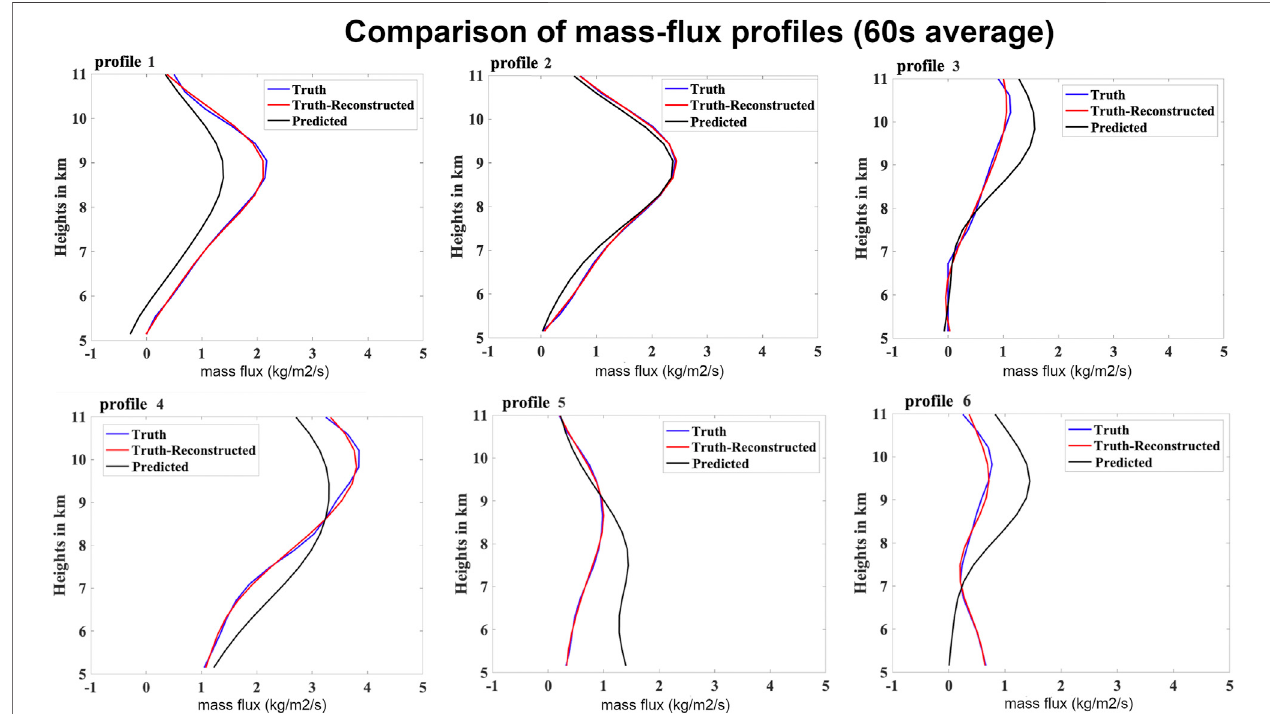
FIGURE10| Sixexamplesofpro fi lesofverticalmass fl uxretrievedtheTbsobtainedattandt+dt:theTbsareusedtoestimatew max andh max ,whicharecombined to the cloud top height (CTH) and the top three principal components of each pro fi le obtained from a PCA (see text for details). The blue curve is the original pro fi le, and the red curve is the reconstruction of that pro fi le using only its top three principal components. The black curves are the pro fi les retrieved from w max , h max and CTH.